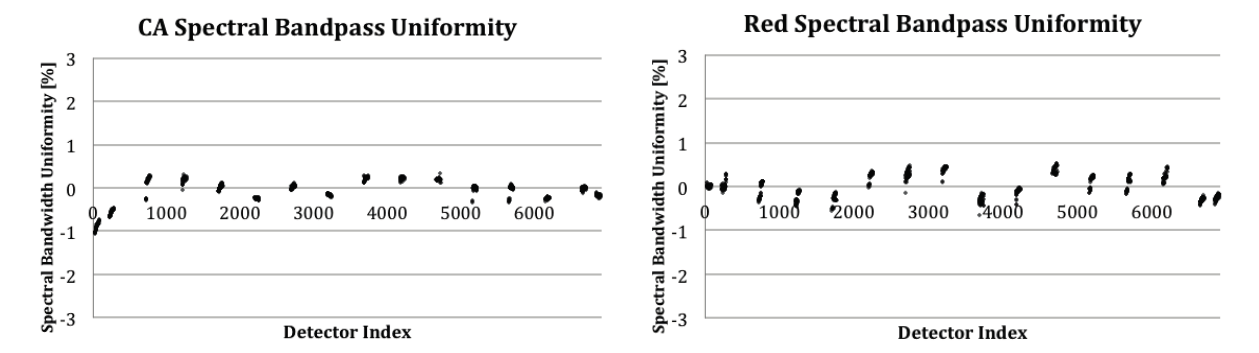
Figure 10. The spectral bandpass uniformity for the CA ( left ) and Red ( right ) bands, as measured by the variation in the bandpass over all detectors tested during the instrument level tests. The uniformity is relative to the median